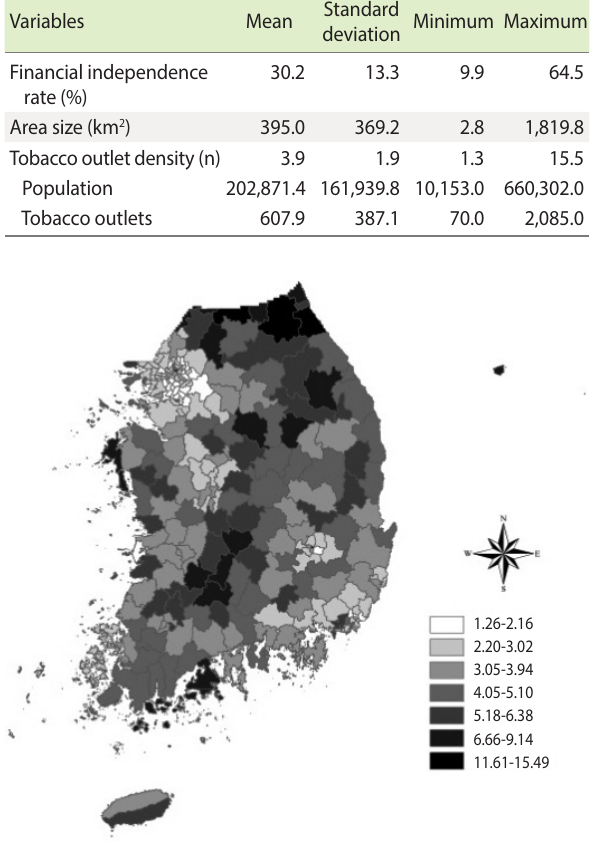
Figure 1. Distribution of tobacco outlet density (per 1,000 persons) across 254 communities in Korea.